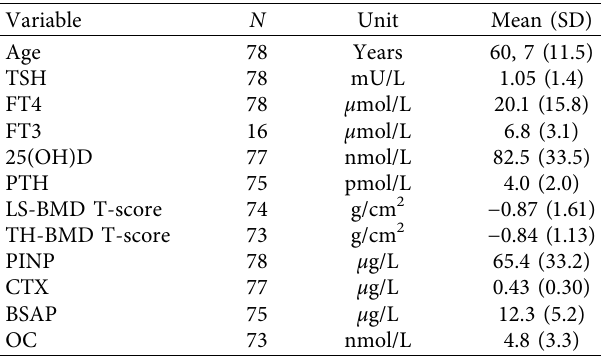
Table 1: Demographics of the population